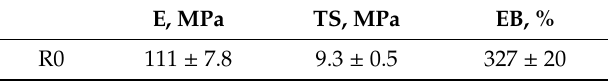
Table 2. Mechanical properties of the virgin